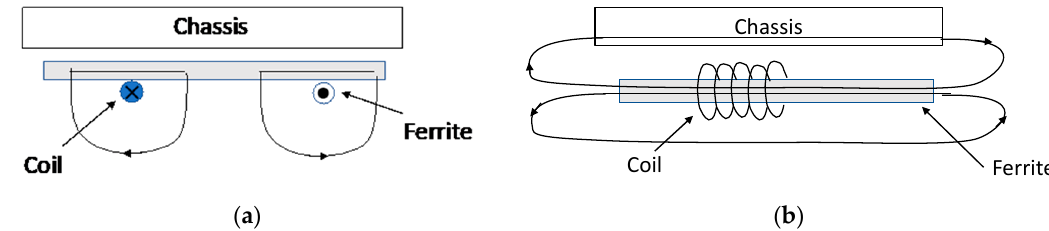
Figure 2. Classification of the magnetic couplers for WPT in single-sided type ( a ) and double sided-type ( b ) [16].